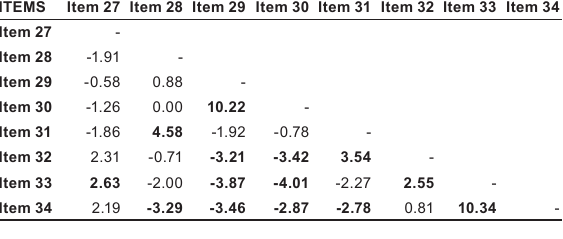
TABLE 7 Standardised residuals for Facilities dimension – Mall intercept